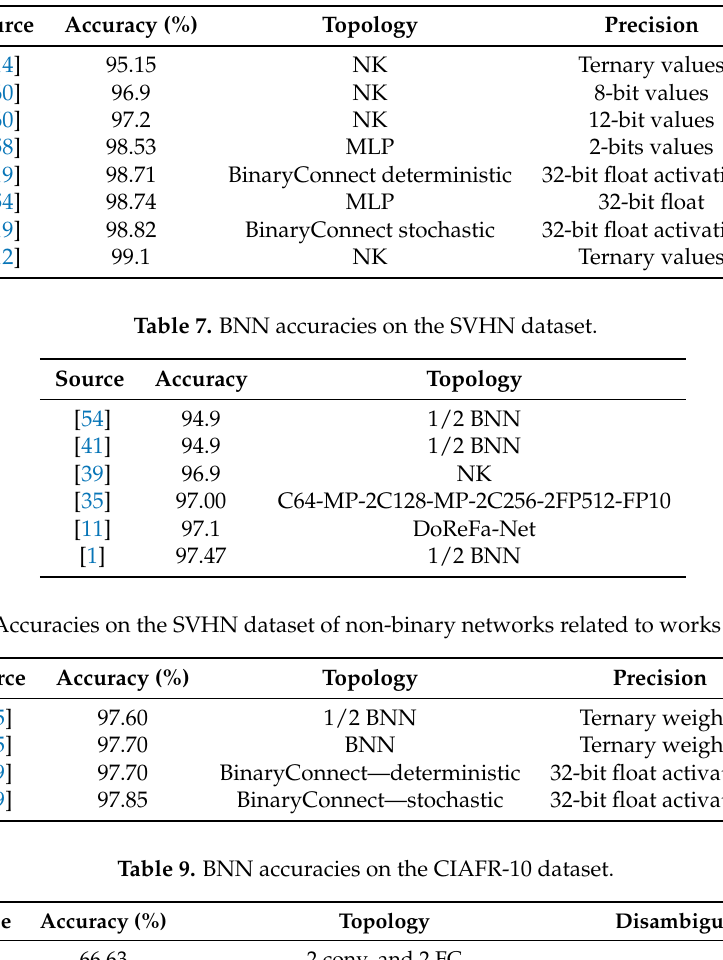
Table 6. Accuracies on the MNIST dataset of non-binary networks related to works reviewed.